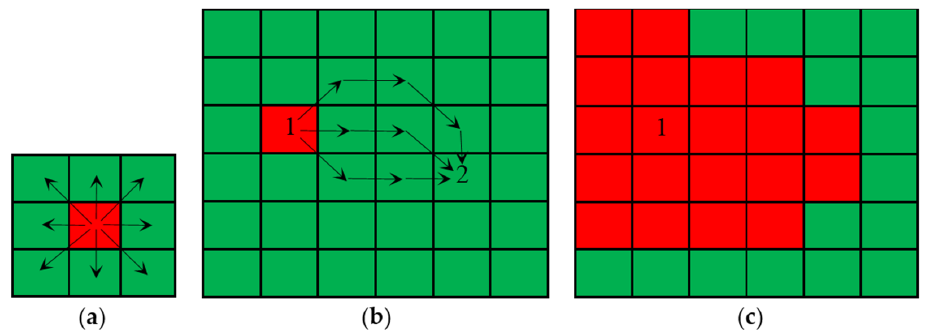
Figure 3. Illustration of wildfire spread modeling: ( a ) eight possible spread directions from a burned (red) cell to its adjacent cells; ( b ) example of three (out of the many) possible routes for a fire to spread from the ignition cell (cell 1) to another cell (cell 2) in a rasterized landscape; ( c ) example of the fire’s maximum spread range (MSR, red cells; detailed explanation of MSR is in Appendix A.2). Each fire starts at time zero from its ignition cell (Equation (6)) and will not burn non ‐ flammable cells or cells lying outside its MSR (Equation (7)):